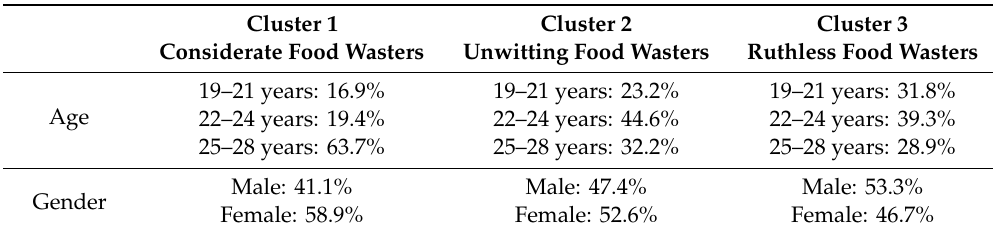
Table 5. Age and gender based on